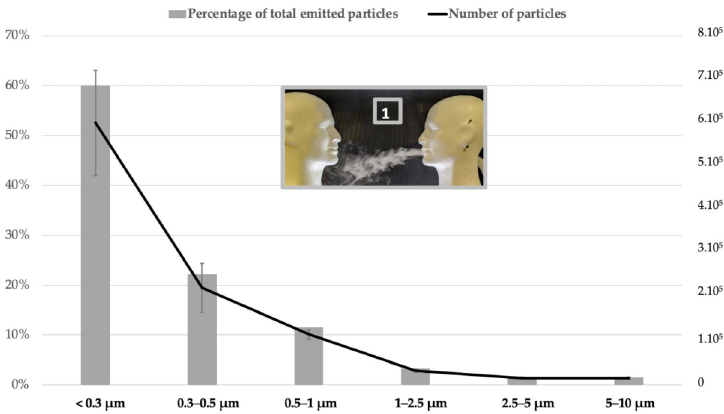
Figure 4. Particles distribution received at 25 cm without any PPE (situation 1).